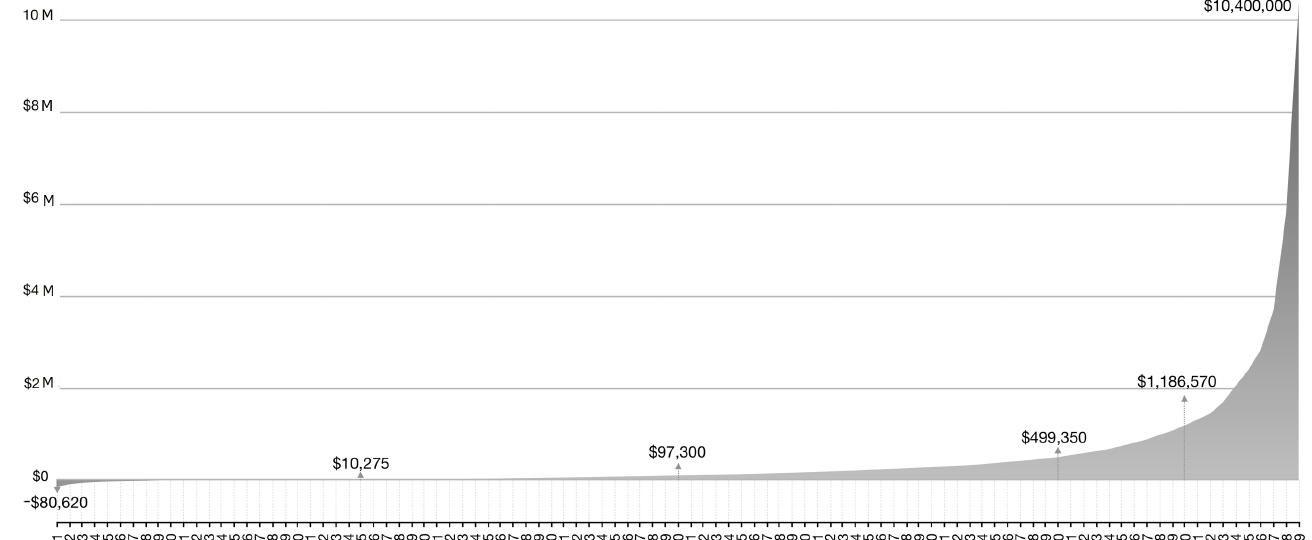
Figure 1. Distribution of household wealth in US 2016 [22]. Meta-heuristics method, particle swarm optimization (PSO) in particular, is used to find optimal taxation given the constraints of a simple majority democracy with a yardstick vote. Results show that the policymaker tends to a taxation regime that is highly punitive for a moving minority in order to win the election by benefiting others. Such decision- making leads to a cyclic taxation policy with punitive taxation targeting sequential portions of the